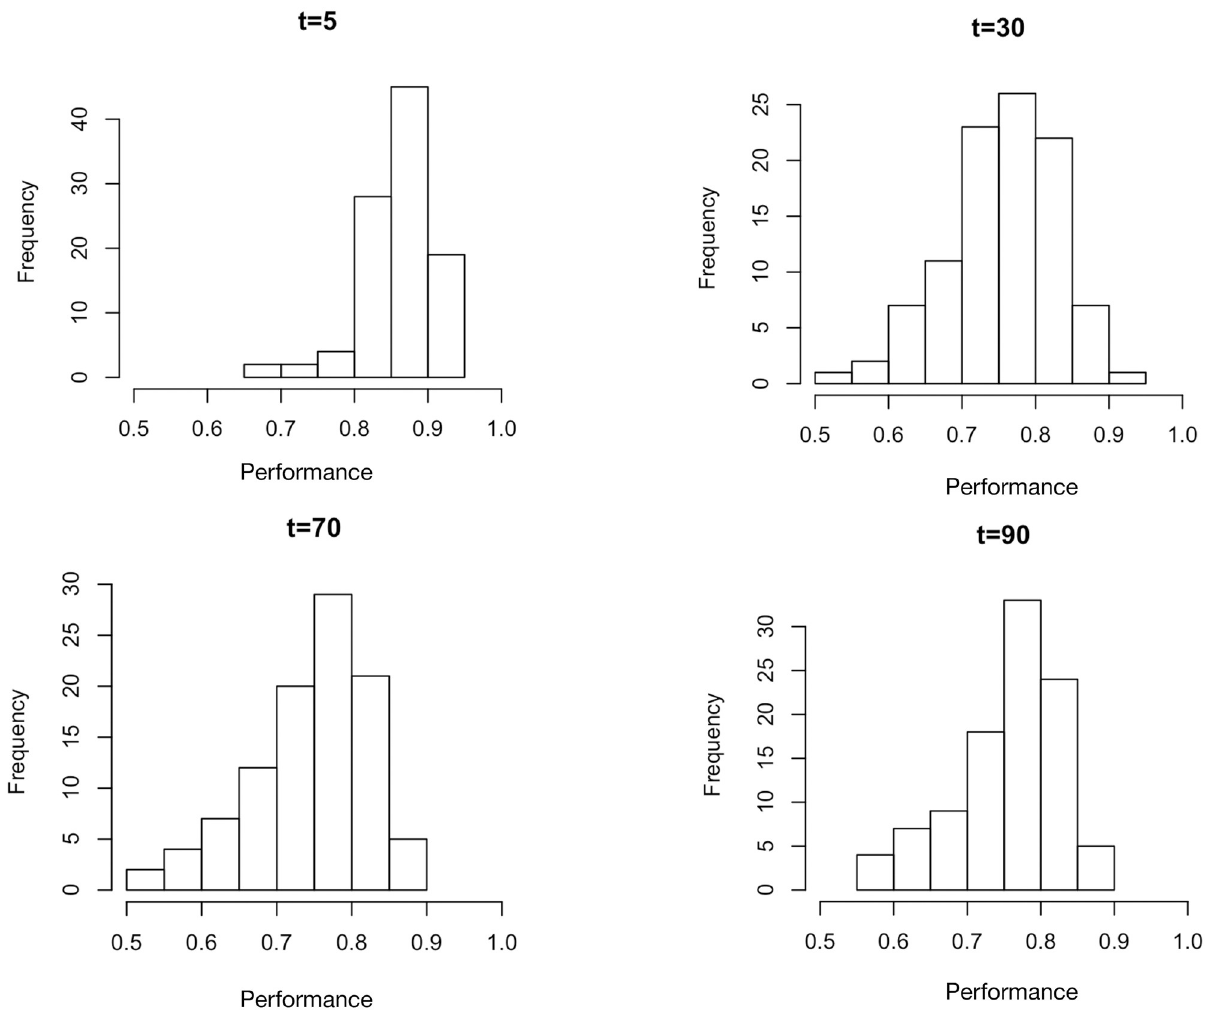
Fig 8. Frequency of the distribution of performance (Eq 6) at four different times, for p ud = 0.08 and p du = 0.2, with parameters for the performance function n 50 = 20, σ = 10, n 0 ¼ 40 , and s 0 ¼ 10 . Note the left tail of the distributions expanding as time increases and an approach to a n 50 n steady state frequency distribution of